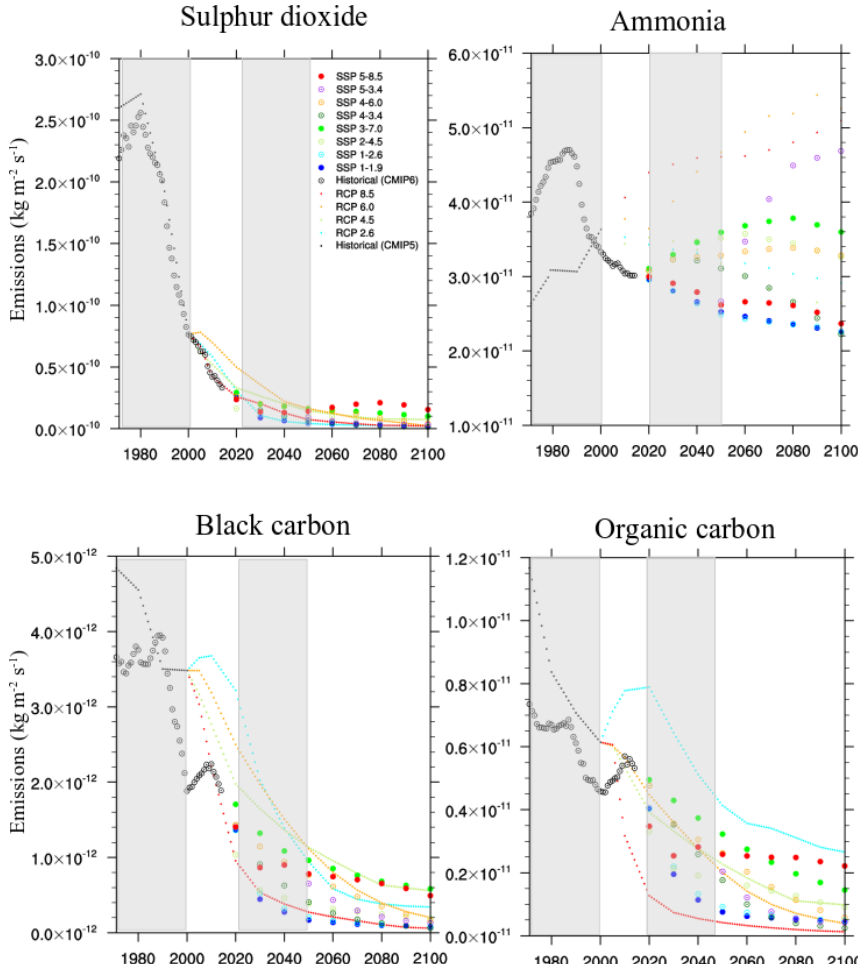
Figure 2. CMIP5 and CMIP6 emissions (kgm − 2 s − 1 ) over Europe from the main activity sectors (residential, agriculture, energy, industrial, air, land and sea transport, waste and solvents) for sulfur dioxide, ammonia, black carbon and organic carbon. The large filled dots symbolize the three scenarios chosen for this study (SSP 1-1.9, SSP 3-7.0 and SSP 5-8.5). Shaded bars highlight the past and future simulations